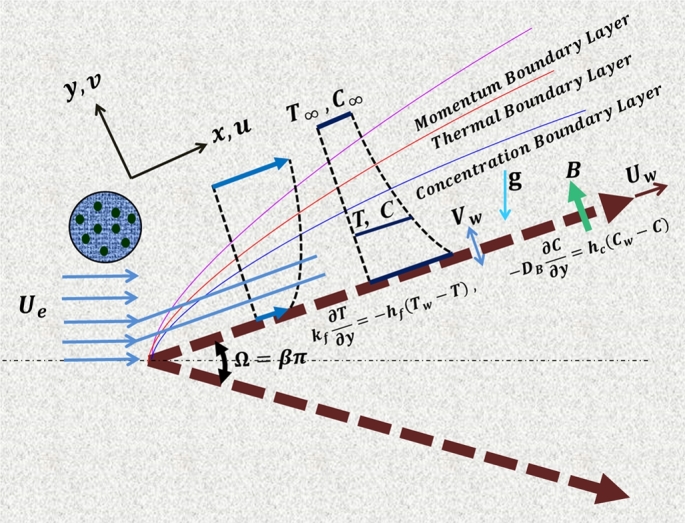
Flow configuration and coordinate system.